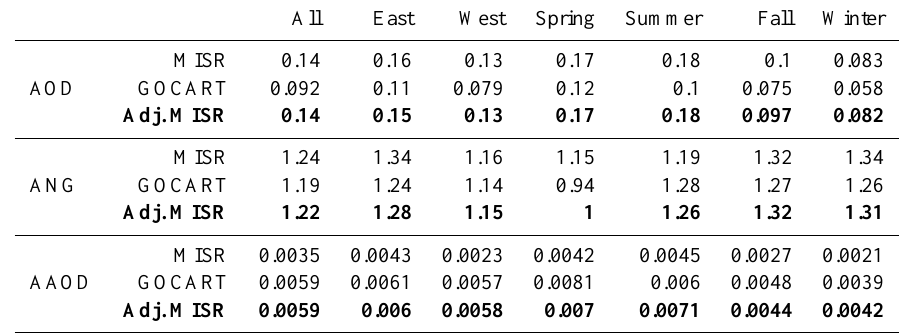
Table 3. Mean values of MISR, GOCART, and our work’s aerosol optical properties over the contiguous USA. All